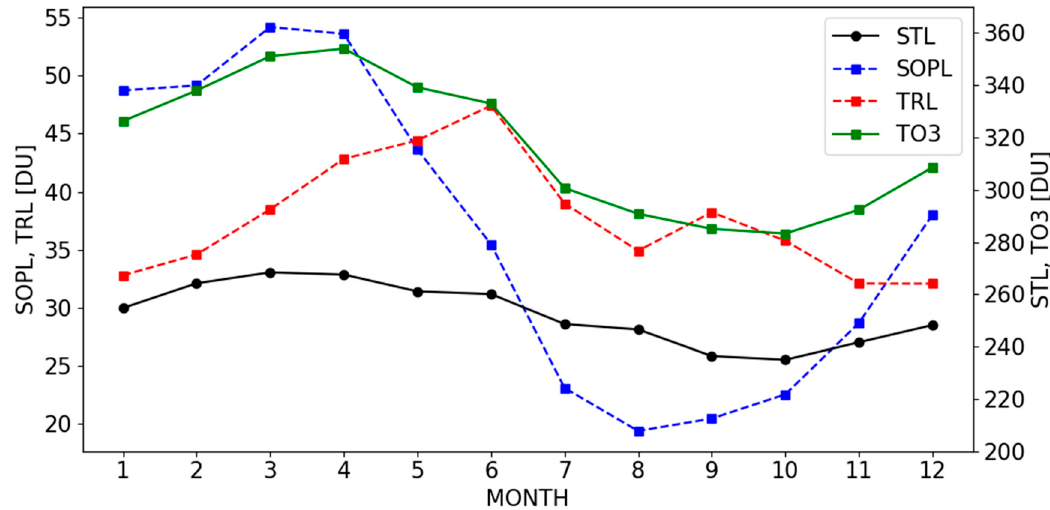
Figure 2. Monthly variation of each ozone layer (SOPL: second ozone peak layer, TRL: tropospheric layer, STL: stratospheric layer, TO3: total column ozone).